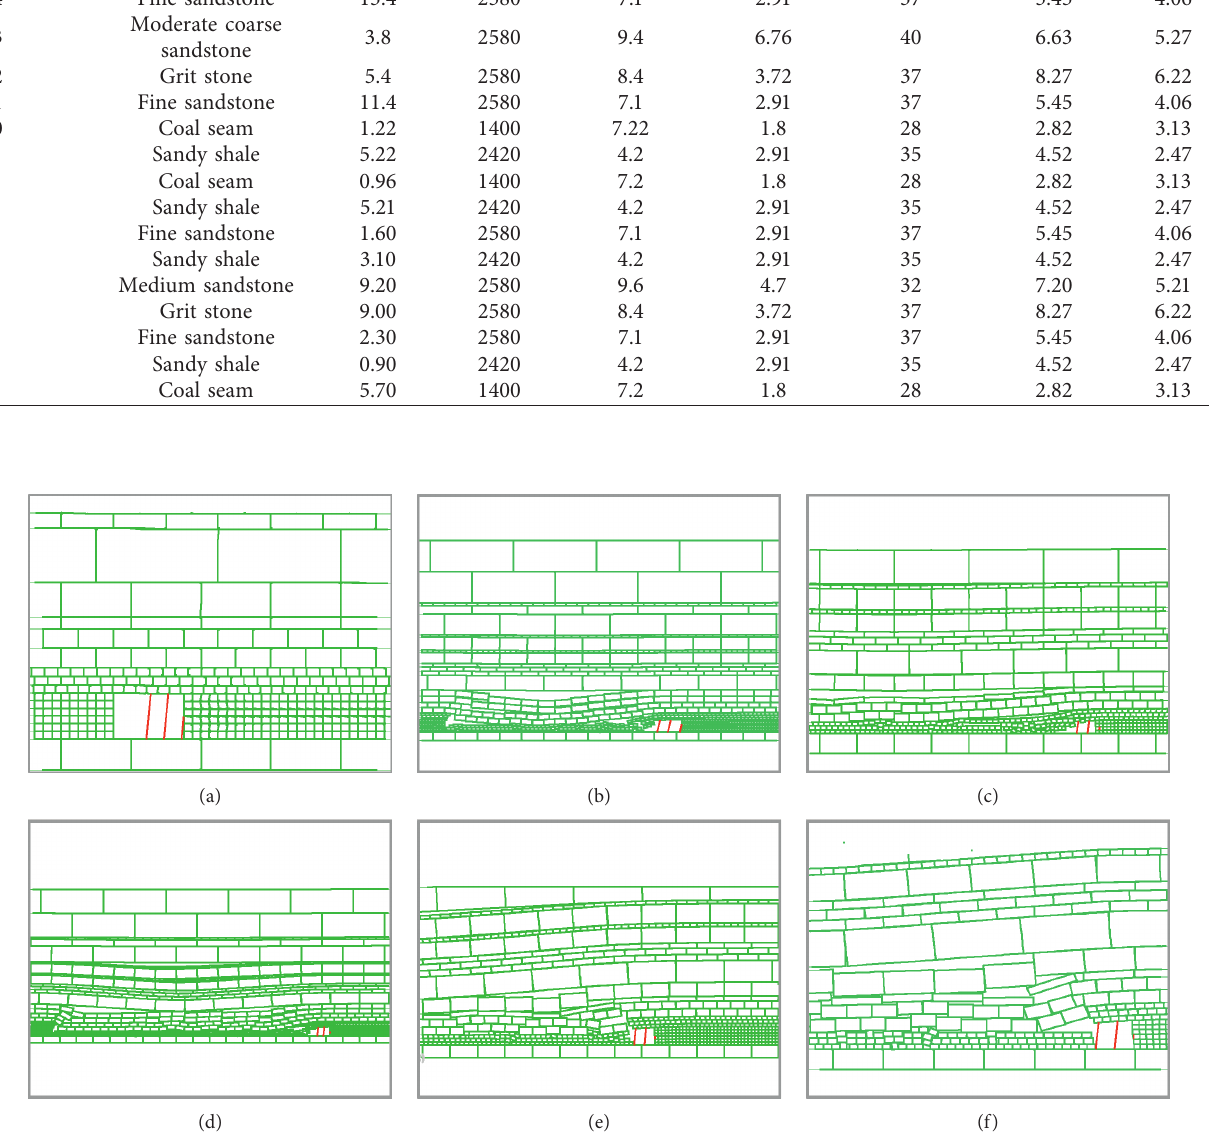
Figure 3: Numerical simulation of overburden failure mode. (a) Open-off cut position; (b) working face advanced to 52 (m); (c) working face advanced to 66 (m);(d) working face advanced to 92 (m); (e) first periodic collapse of basic roof; (f) second periodic collapse of basic